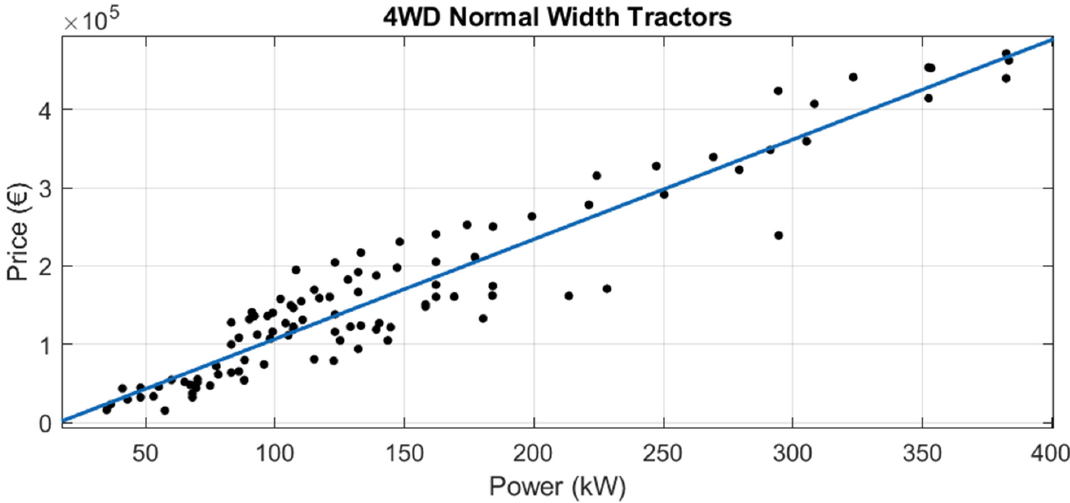
Figure 16. Price vs. power for 4WD normal width new tractors.